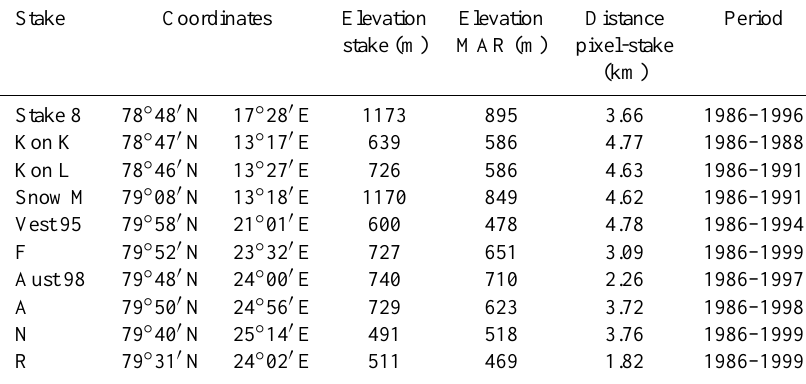
Table 5. Sites of Pinglot et al. (1999, 2001) used in the comparison.